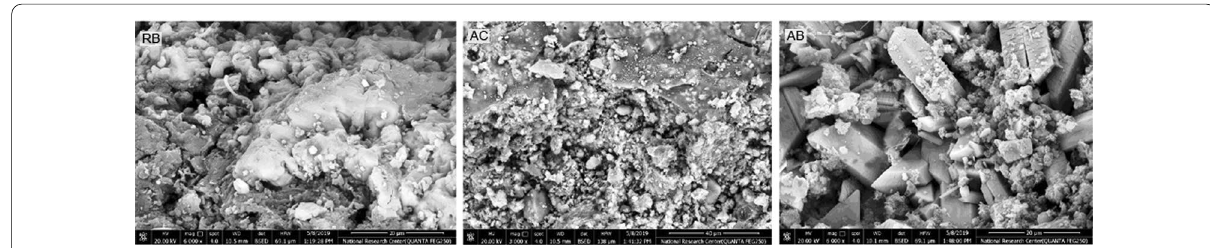
Fig. 4 SEM images of RB, AC, and AB